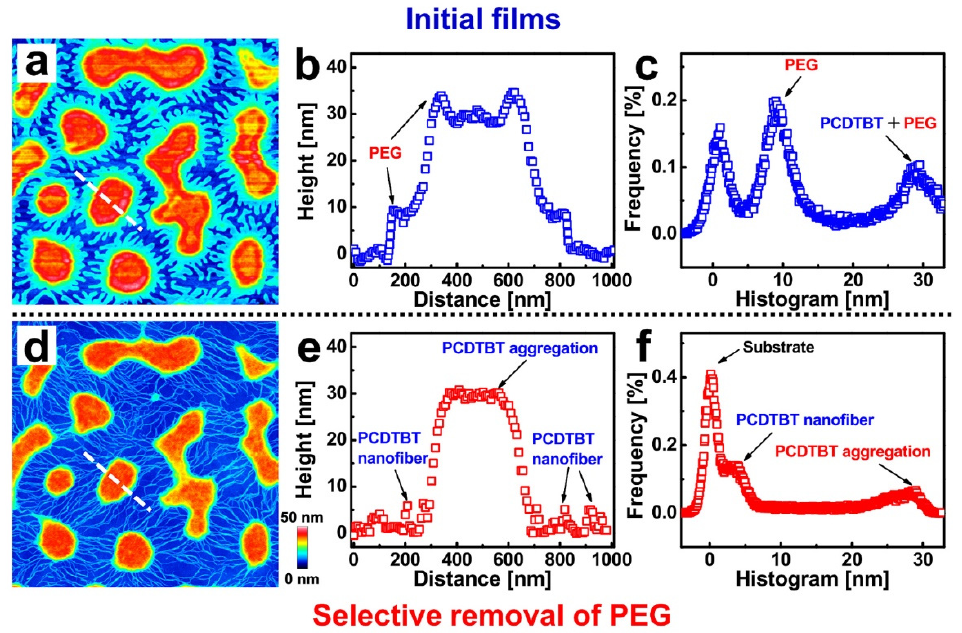
Figure 1. Morphology of PCDTBT-PEG blend film. ( a , b ) AFM topographical images of a typical PCDTBT/PEG (weight ratios of 5/5) blend film and the corresponding washed film after selective removal of PEG using acetone. ( b , e ) Height distributions along the white dashed lines in ( a , d ). ( c , f ) Height histograms obtained from the AFM images shown in ( a , d ). The size of each AFM image is 3 × 3 μ m 2 .